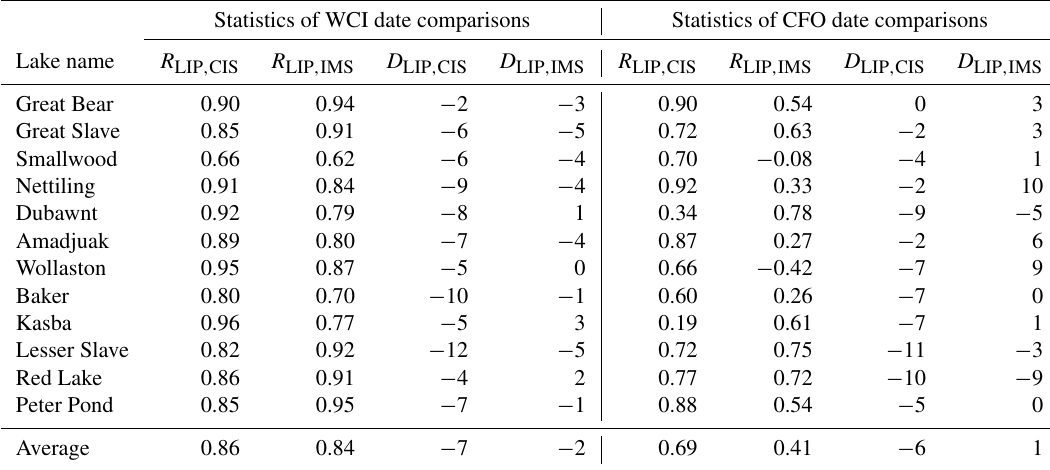
Table 2. Summary of the comparison results for water clear of ice (WCI) and complete freeze over (CFO) dates derived from AMSR Lake Ice Phenology (LIP), Canadian Ice Service (CIS) datasets for the period 2002–2015, and the NOAA/IMS (IMS) dataset for the period 2004– 2015. R LIP,CIS/IMS denotes the correlation coefficient between the LIP and CIS/IMS datasets; D LIP,CIS/IMS is the average difference (unit: day) in WCI or CFO dates calculated by LIP minus